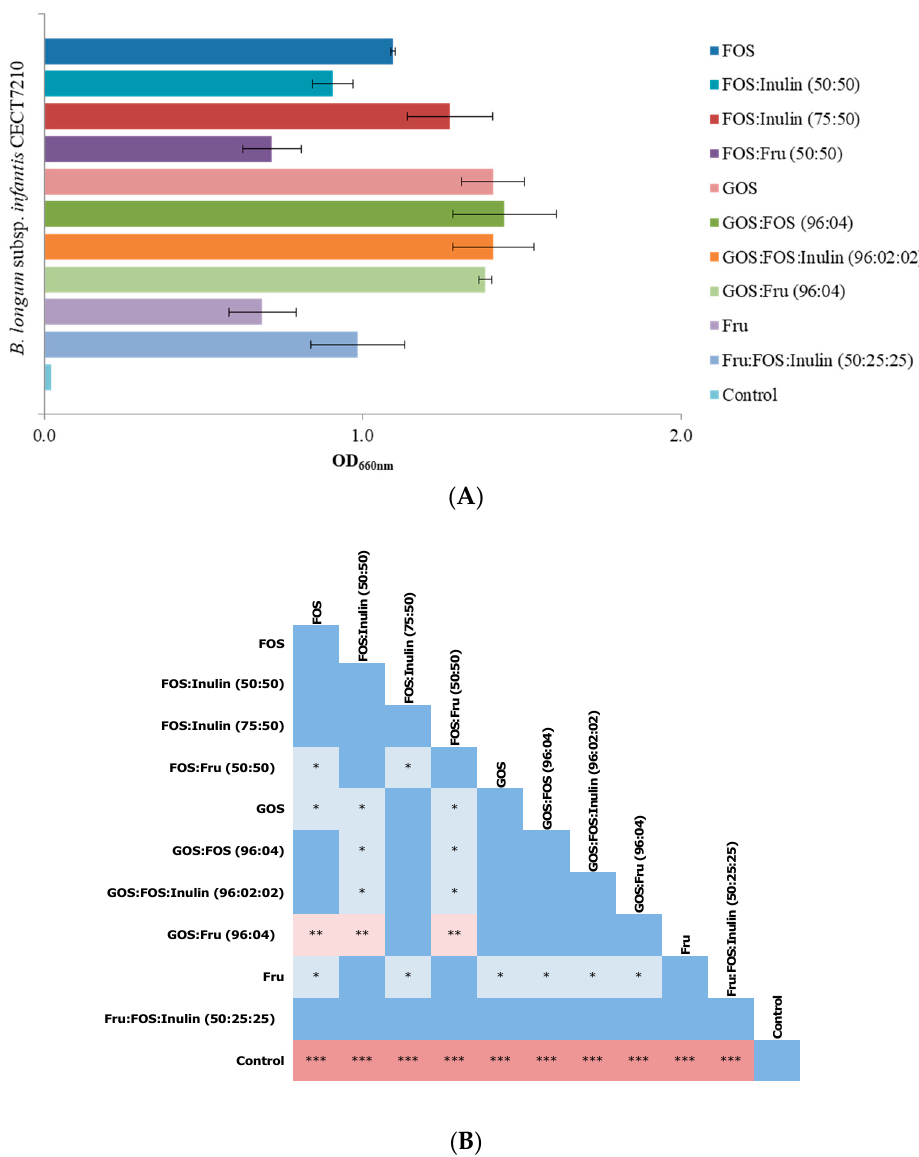
Figure 1. Effect of prebiotics on the growth of B. infantis IM-1 ® after 24 h of incubation. ( A ) Optical density (OD 660 nm ) of the cultures of the B. infantis IM-1 ® strain grown in the presence of different prebiotic substrates. The represented data are means of at least three independent replicates. ( B ) Statistically significant differences in growth of B. infantis IM-1 ® in the presence of different prebiotics were determined, using Student’s t -test for each pair of substrates tested. Color key: dark blue: p > 0.05; light blue: * p < 0.05; light red: ** p < 0.01; and dark red: *** p . < 0.001. FOS, fructooligosaccharides; GOS, galactooligosaccharides; Fru; Frutalose, and control (MRSFc: Man, Rogosa and Sharpe broth with 0.05% of L-cysteine hydrochloride monohydrate. MRSFc without prebiotic supplementation).